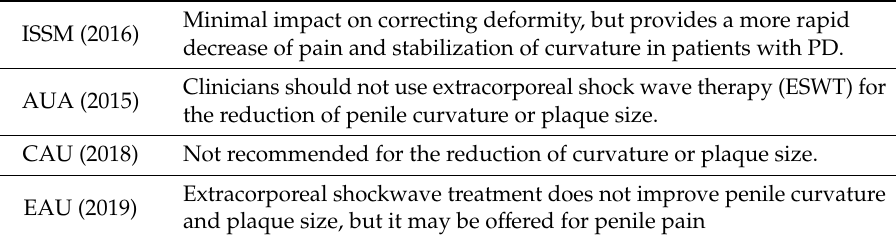
Table 4. Guidelines on Extracorporeal Shockwave Therapy (ESWL) for Peyronie’s Disease.